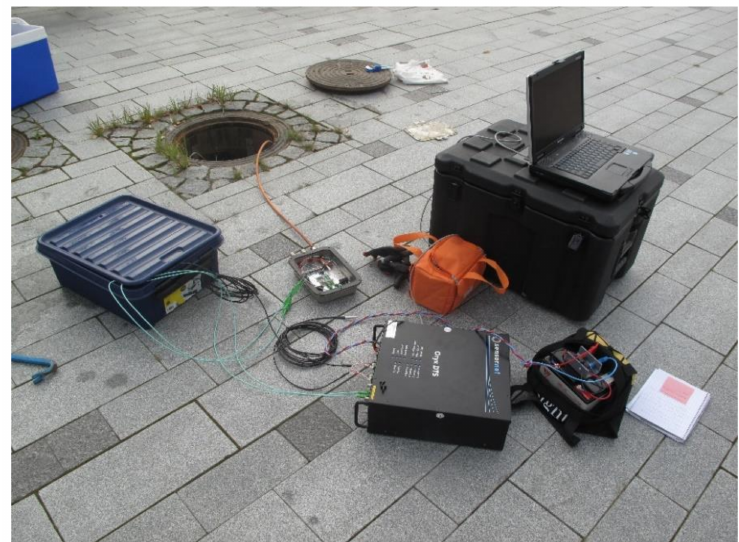
Figure 3. Sensornet Oryx DTS device that can be used even in outdoor